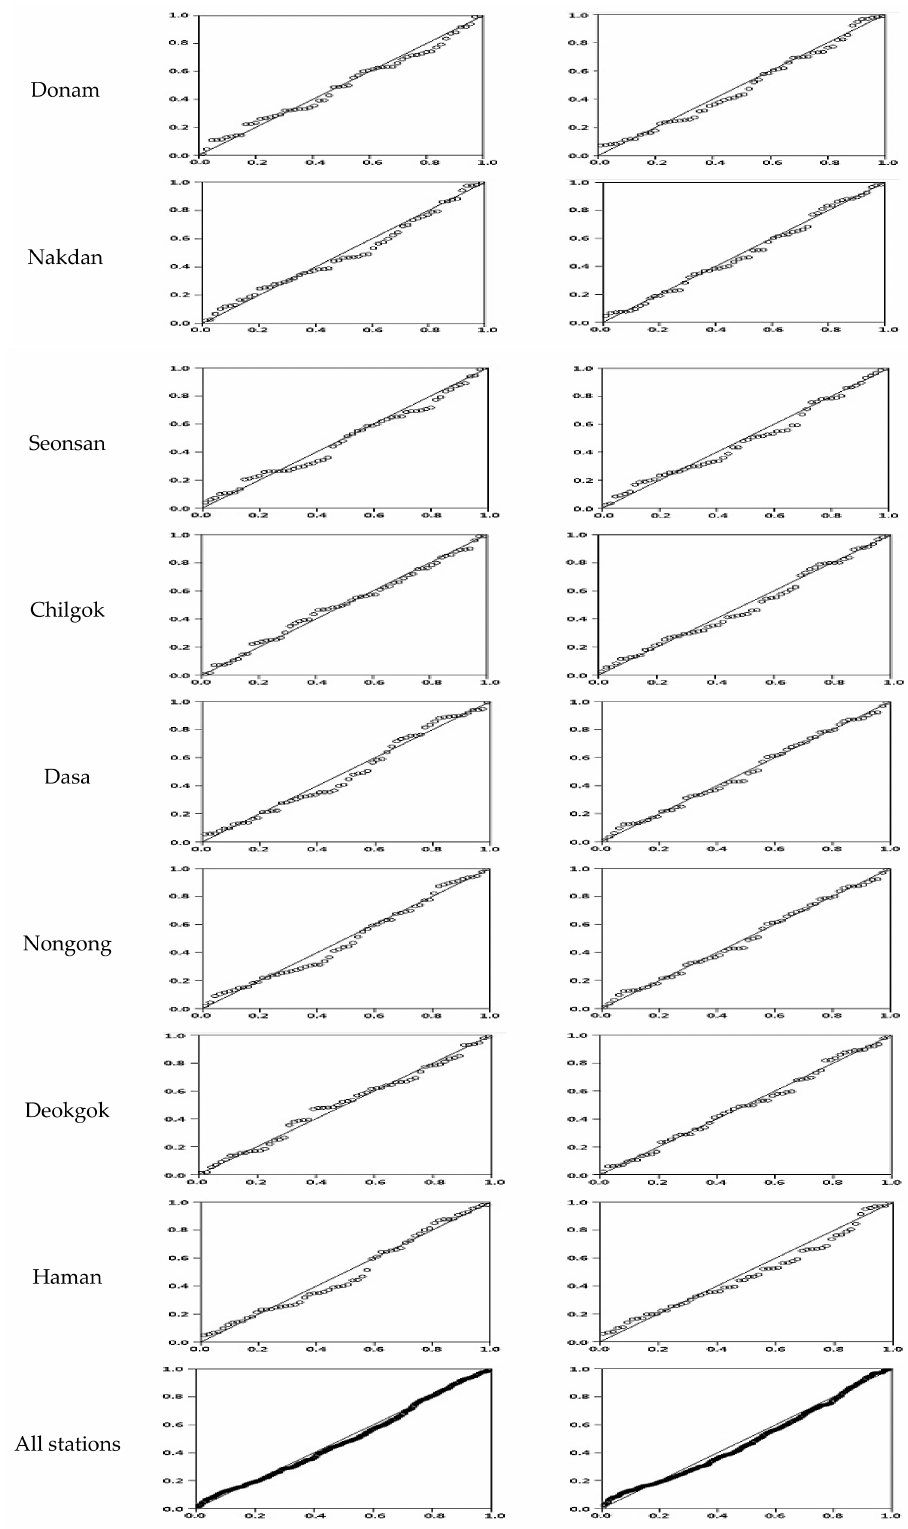
Figure A1. Normal P-P plots of the regression standardized residual between the observed ( x -axis) and estimated ( y -axis) cumulative probabilities for the total (left) and fecal (right) coliforms at each weir